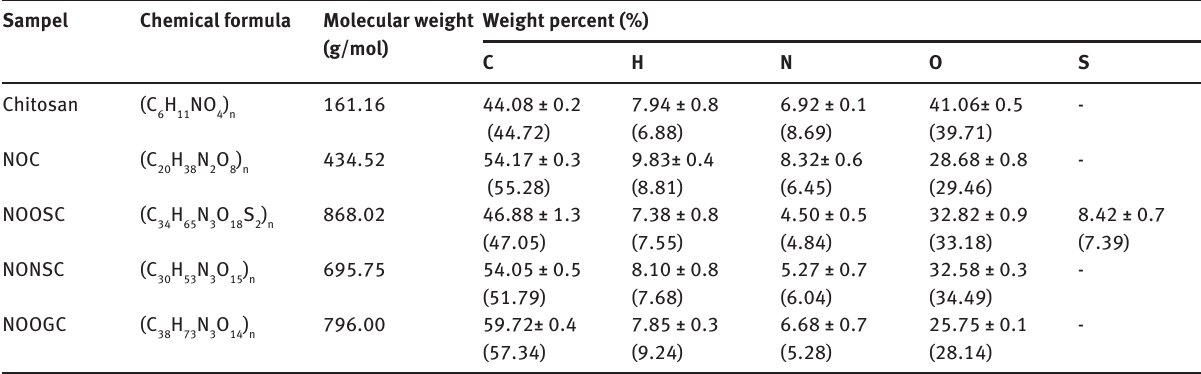
Table 1 : The elemental composition of chitosan, NOC, NOOSC, NONSC and NOOGC. Sampel